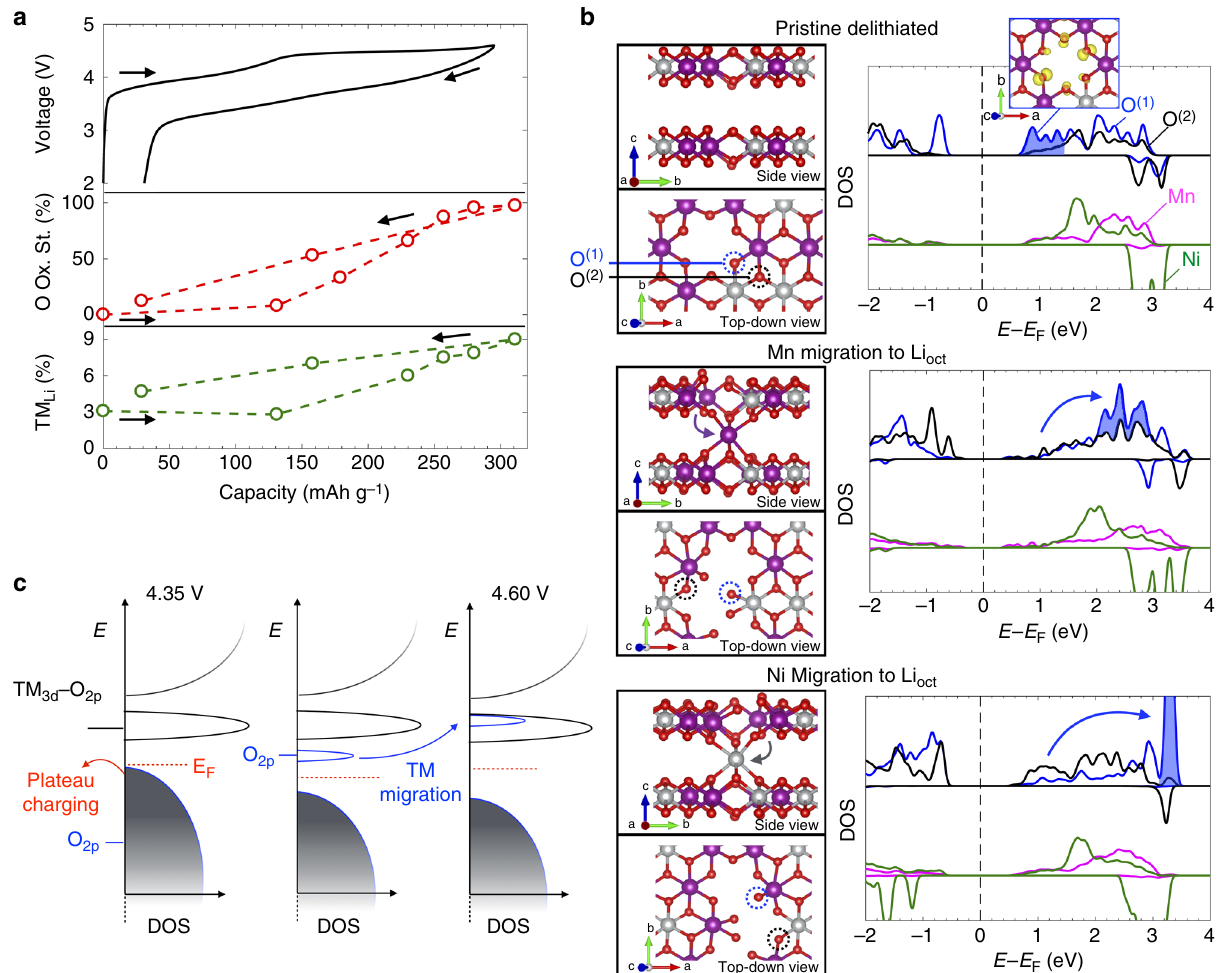
Fig. 6 Effect of TM migration on electronic structure. a Plot of the O fractional oxidation state (red) and the migrated TM fraction (green) as a function of capacity, showing the clear link between hysteresis in the TM migration and voltage hysteresis in the O redox. Error bars indicating fi tting residual and re fi nement error for the O oxidation state and TM migration fraction, respectively, are smaller than the data symbols and are therefore not shown. b pDOS for the TMs and the two-coordinate (O (1) , blue) and three-coordinate (O (2) , black) oxygen environments in the pristine delithiated state (top), and after Mn (middle) and Ni (bottom) migration into octahedral sites in the Li layer. The integrated charge density for the lowest unoccupied states in the pristine delithiated structure (blue shaded area of the pristine DOS) is shown in the top right inset. The total TM pDOS is normalized by the number of TMs in the supercell for comparison with the single-site oxygen pDOS. Schematics of each supercell used to generate the pDOS are shown to the left, with the plotted O (1) and O (2) oxygen environments circled. c Schematic of the reorganization of the electronic structure due to TM